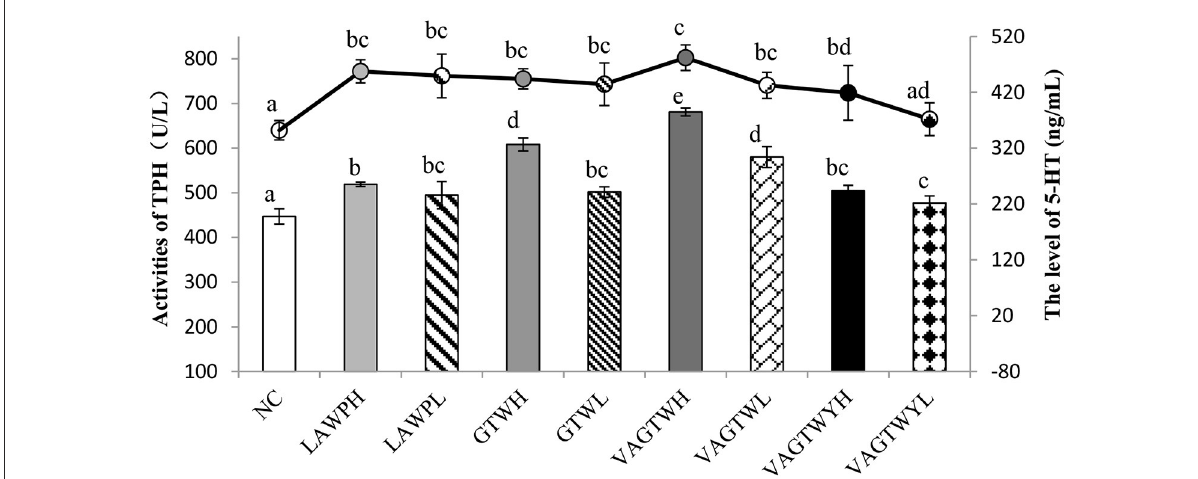
FIGURE3 Effect of Trp peptides on the activity of THP and level of 5-HT in zebrafish . NC group (the normal control group for treatment with normal water); LAWPH (the group for treatment with β -lactoglobulin Trp peptides at a high dose: 500 µ g/ml); LAWPL (the group for treatment with β -lactoglobulin Trp peptides at a low dose: 56 µ g/ml); VAGTWYH (the group for treatment with Val-Ala-Gly-Thr-Tyr-Trp at a high dose: 500 µ g/ml); VAGTWYL (the group for treatment with Val-Ala-Gly-Thr-Tyr-Trp at a low dose: 56 µ g/ml); VAGTWH (the group for treatment with Val-Ala-Gly-Thr-Tyr-Trp at a high dose: 500 µ g/ml); VAGTWL (the group for treatment with Val-Ala-Gly-Thr-Tyr-Trp at a low dose: 56 µ g/ml); GTWH (the group for treatment with Gly-Thr-Trp at a high dose: 500 µ g/ml); GTWL (the group for treatment with Gly-Thr-Trp at a low dose: 56 µ g/ml). Data are expressed as the mean ± SD ( n = 30), and ANOVA was performed to evaluate the difference, followed by the Duncan post-hoc test. The bar graph and the line graph show the activities of TPH (the left ordinate) and the level of 5-HT (the right ordinate), respectively. Different letters indicate a significant difference ( p < 0.05).